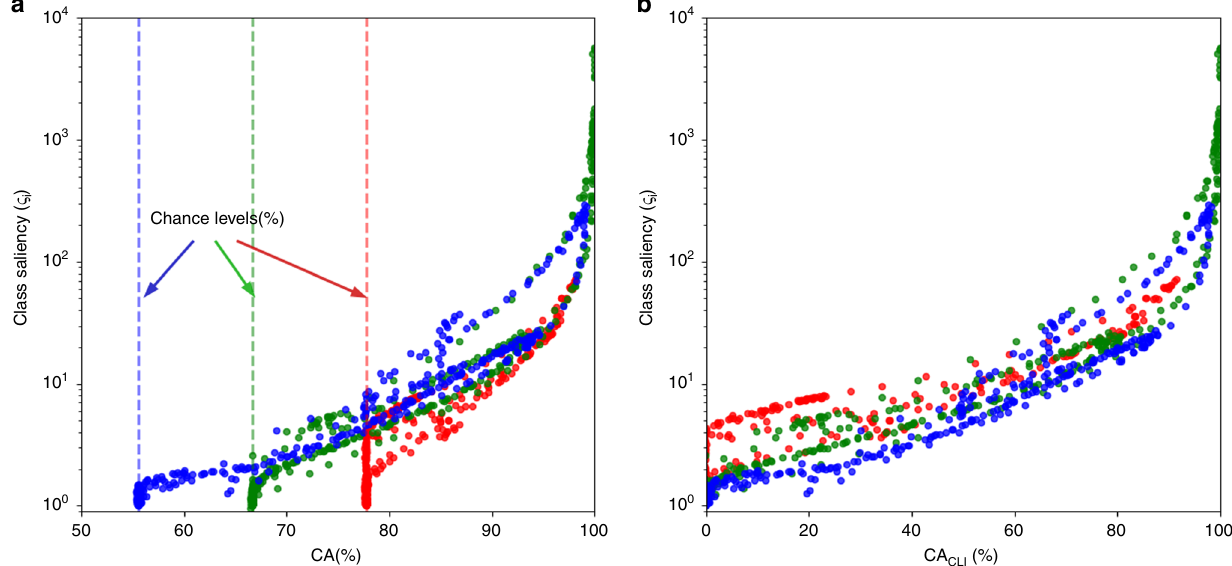
Fig. 4 Class saliency versus the classi fi cation accuracy achieved using a Bayes classi fi er on the entire feature space ( a ) before and ( b ) after the removal of chance levels. In a , a minimum of chance (%) is guaranteed for the CA (%) associated with each unit, which is indeed not coming from the success of the classi fi cation performed. By using CA CLI (%) on the horizontal axis in b , the chance of occurrence for the units present in the test data does not contribute to the measurement of the classi fi cation accuracy (hence taking on values in the entire range of 0 –